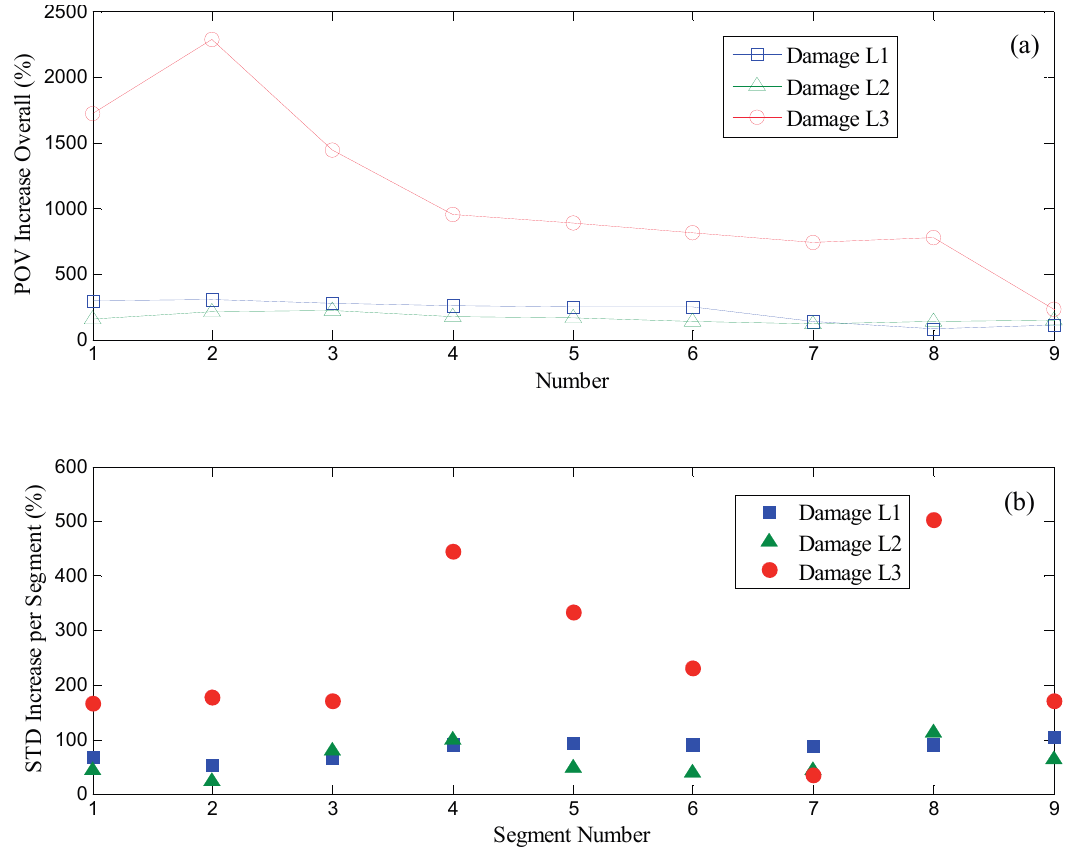
Figure 13. Comparison of increasing ratio between ( a ) the proper orthogonal value of total segments, and ( b ) standard deviation of the first IMF from the wavelet-based de-noised segment ( L1 & L2 : moderate damage, L3 : severe